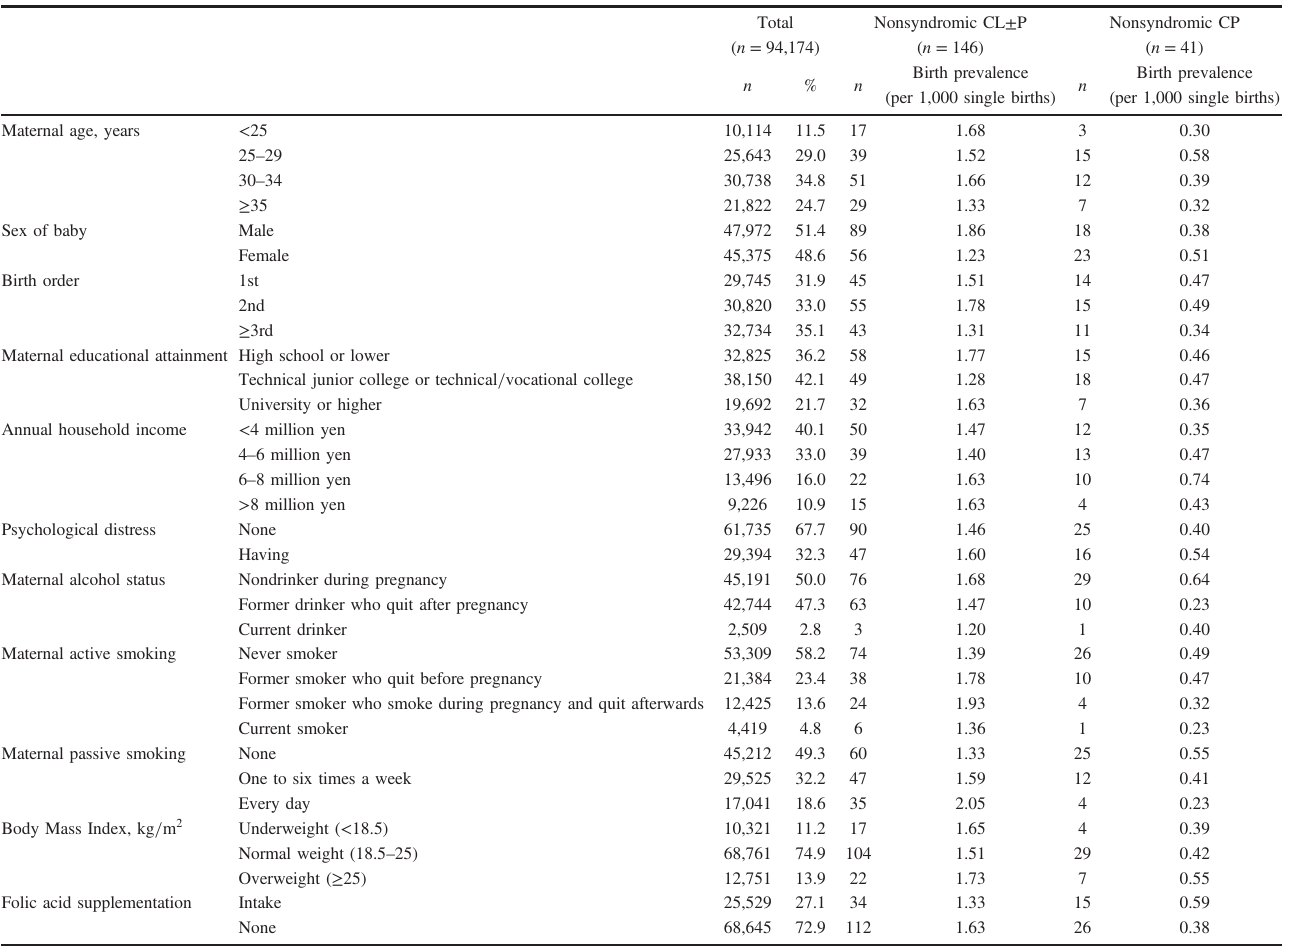
Table 1. Baseline characteristics and the birth prevalence of nonsyndromic orofacial clefts